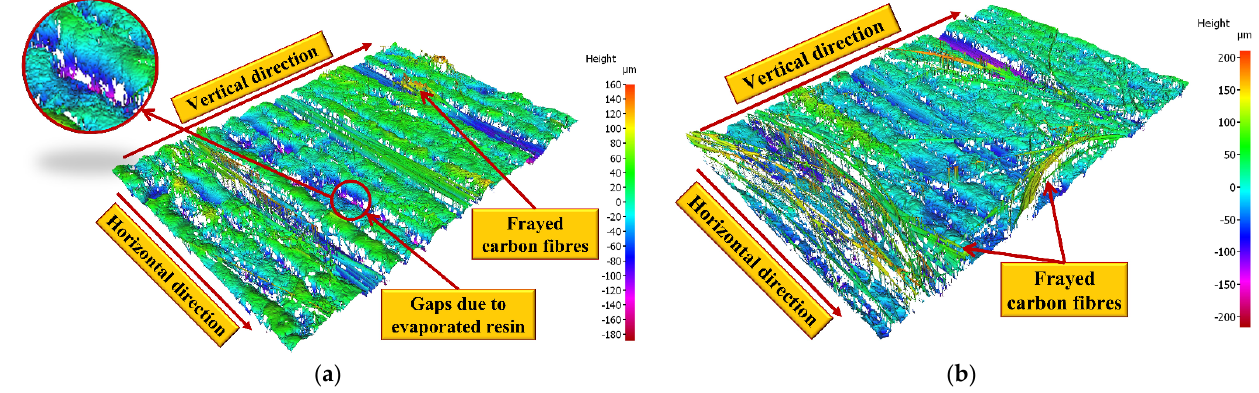
Figure 12. Surface topographical map of workpiece machined with ( a ) Topas (Test 2) and ( b ) Compeed (Test 6) wires.